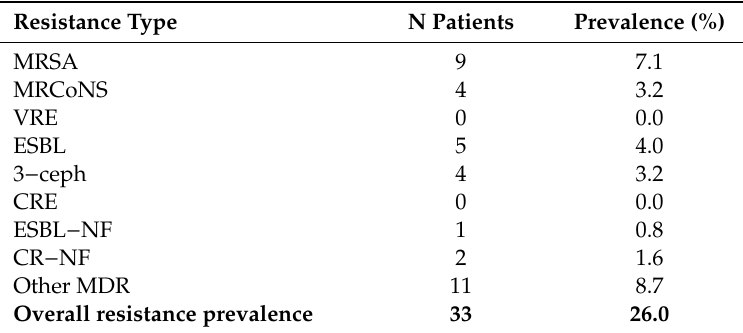
Table 4. Resistance prevalence based on microbiology